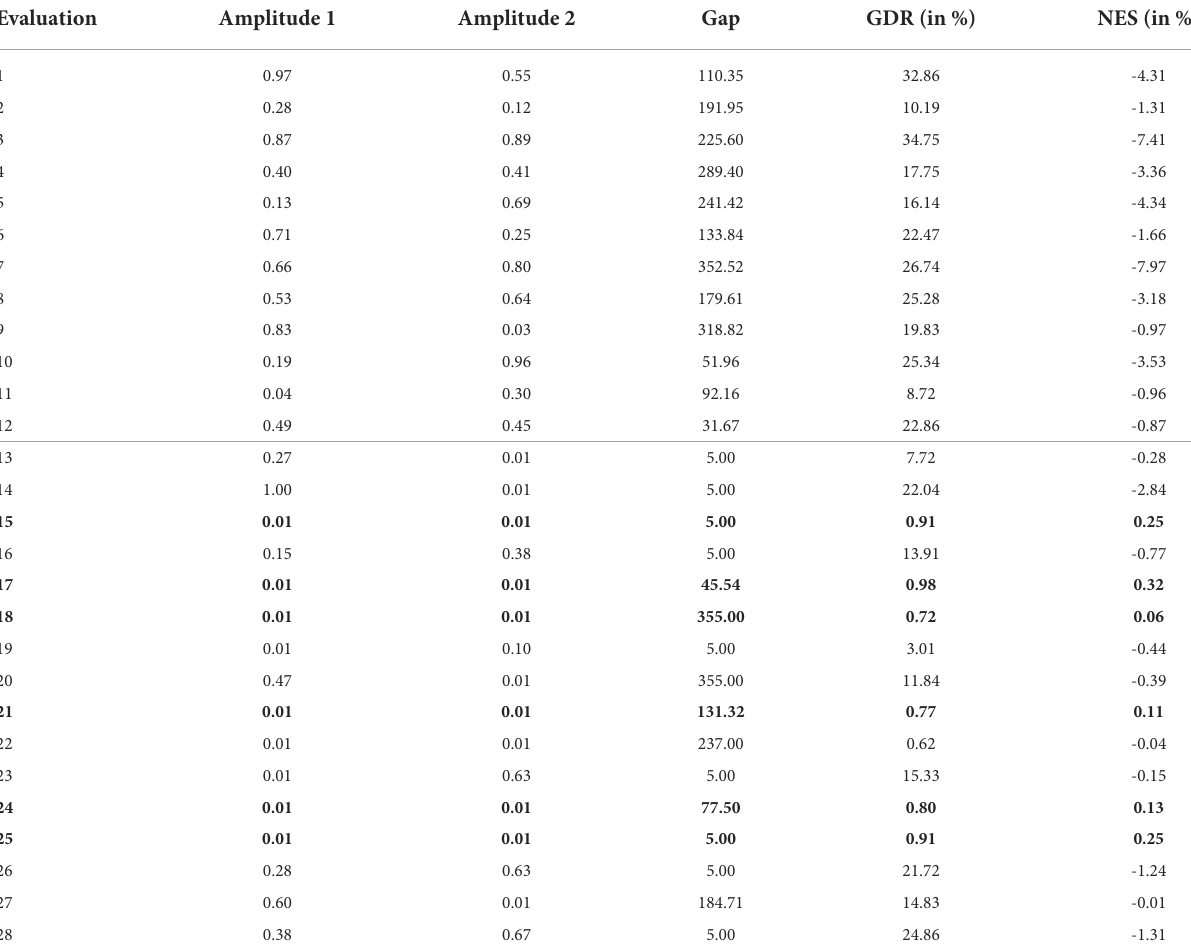
TABLE 8 Results for gap